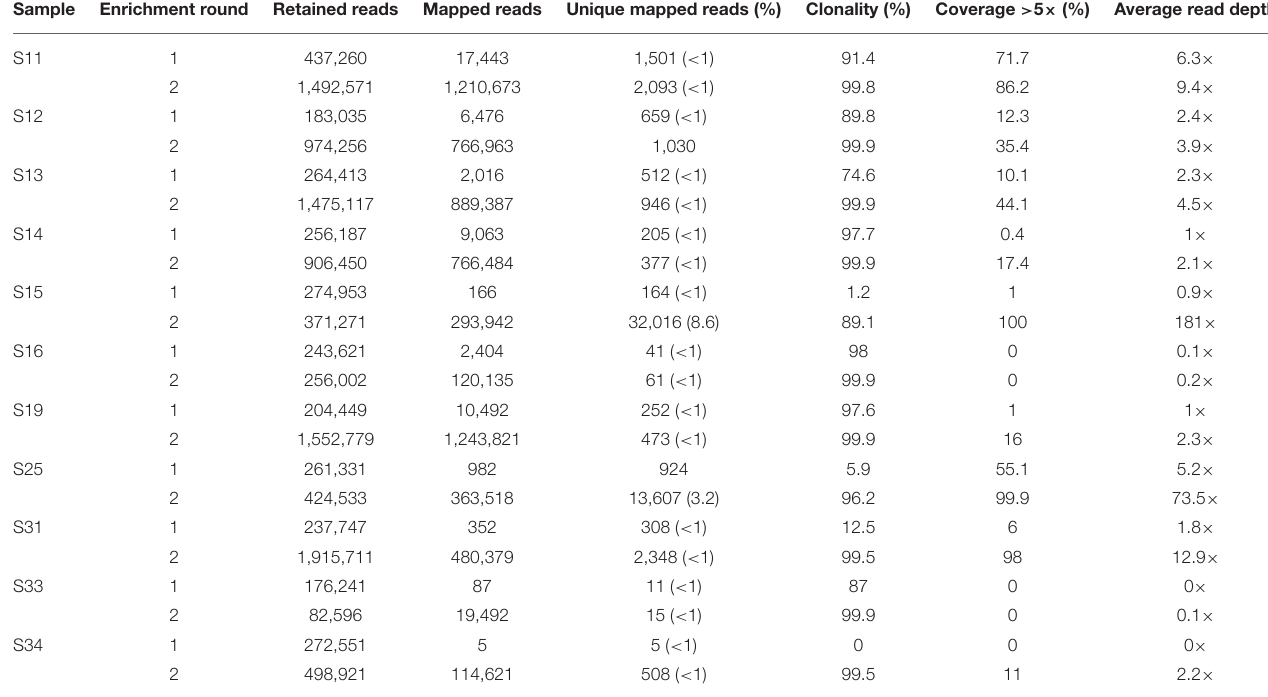
TABLE 2 | Increase in mtDNA genome coverage and read-depth following a second round of enrichment for 11 degraded human bone and tooth